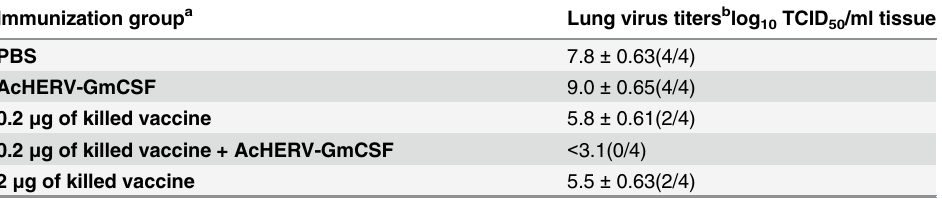
Table 1. Viral recovery in lung tissue of mice challenged with